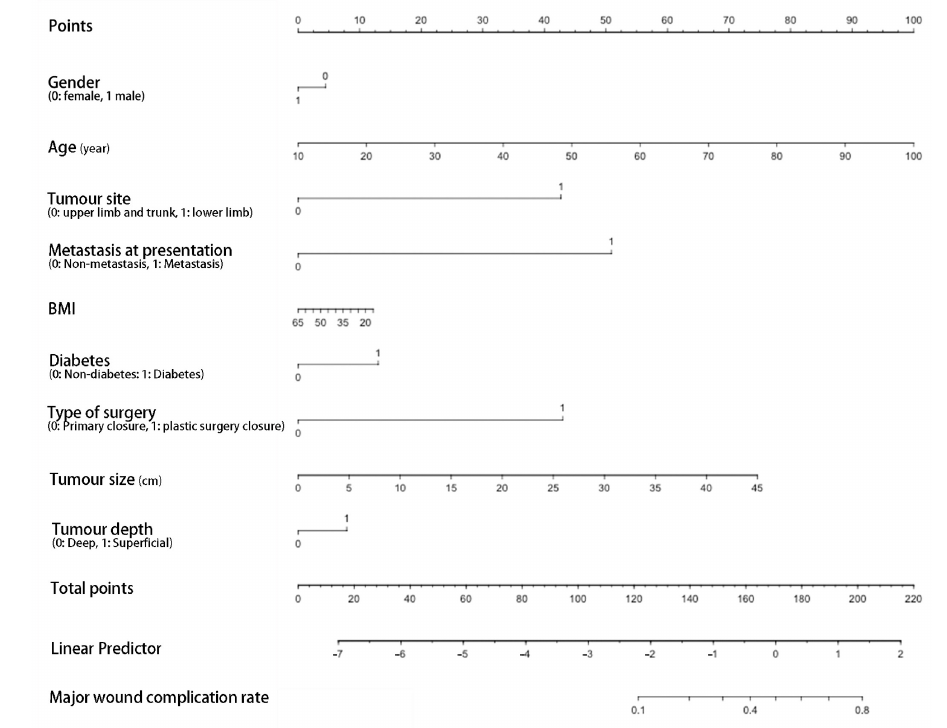
Figure 5. Nomogram 3 (without smoking, use of alcohol, anxiety and depression, SUVmax of PET-CT) for prediction of postoperative major wound complication after preoperative radiotherapy and surgery.